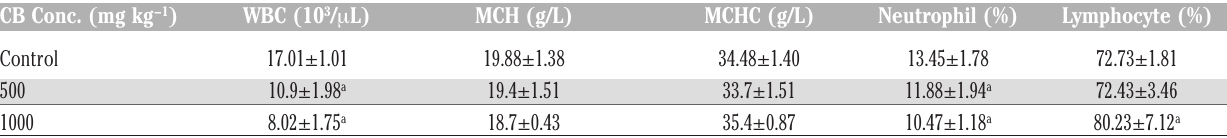
Table 3. Effect of oral administration of class bitters ® on hematological